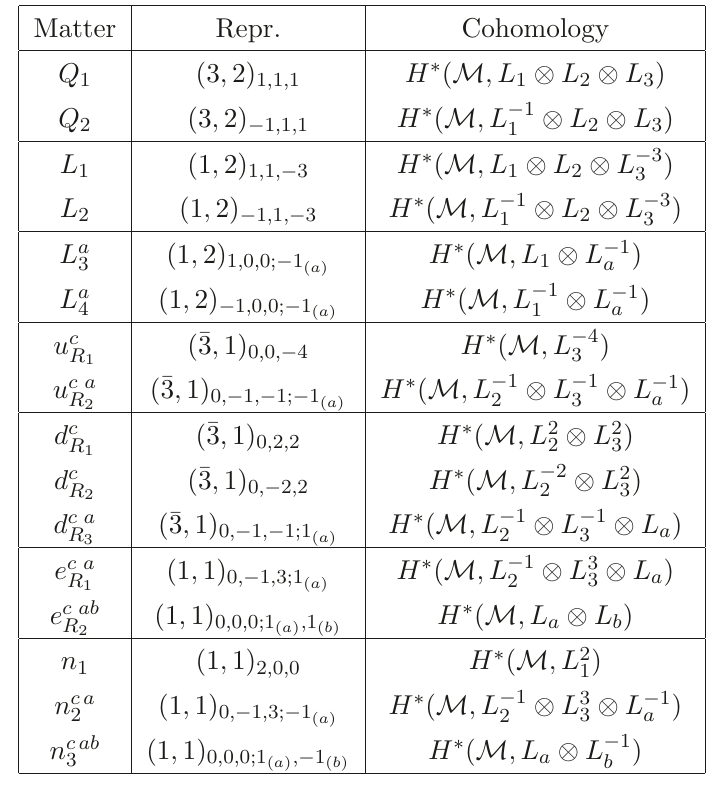
Table 2 . Massless spectrum and corresponding cohomology. In the second column, the subscript indices label the U(1) 1 , 2 , 3 and non-zero U(1) a,b charges.